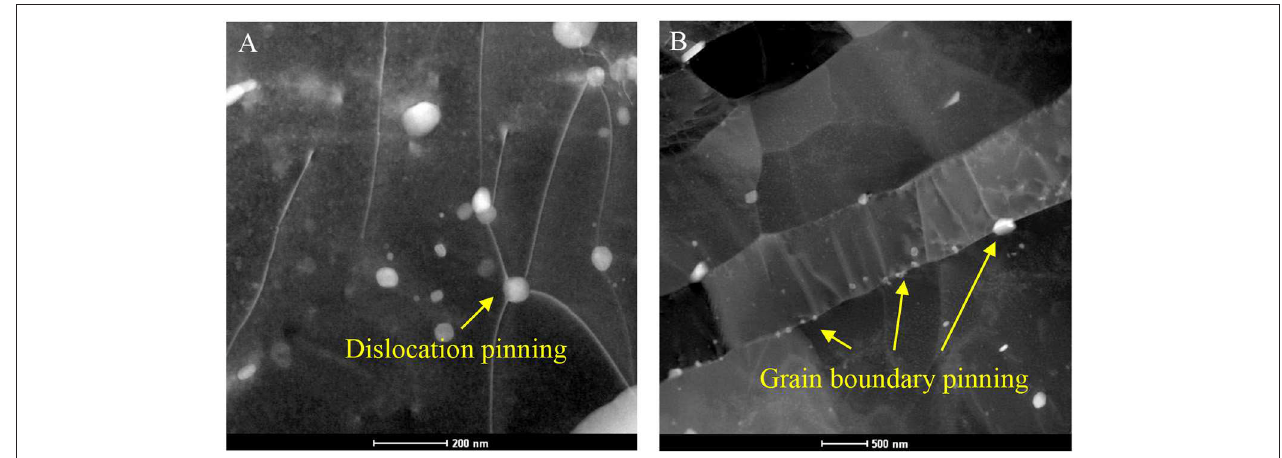
FIGURE 7 | HAADF images of the Sc-containing alloy cold rolling plate annealed at 350 ◦ C for 2h. (A) pinning dislocation; (B) pinning grain